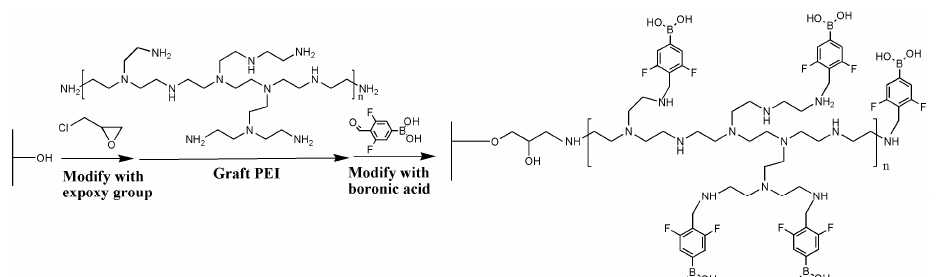
Figure 1. The synthesis scheme of paper@epoxy@PEI-DFFPBA.